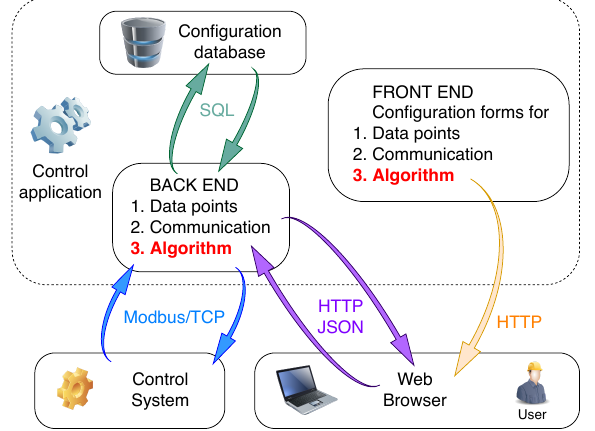
Figure 3. The structure of the developed advanced process control framework. The framework consists of the backend, which is responsible for communicating with a configuration database and the actual industrial control system, and the frontend, which is how users interact with the backend via an intuitive HMI running in the user’s